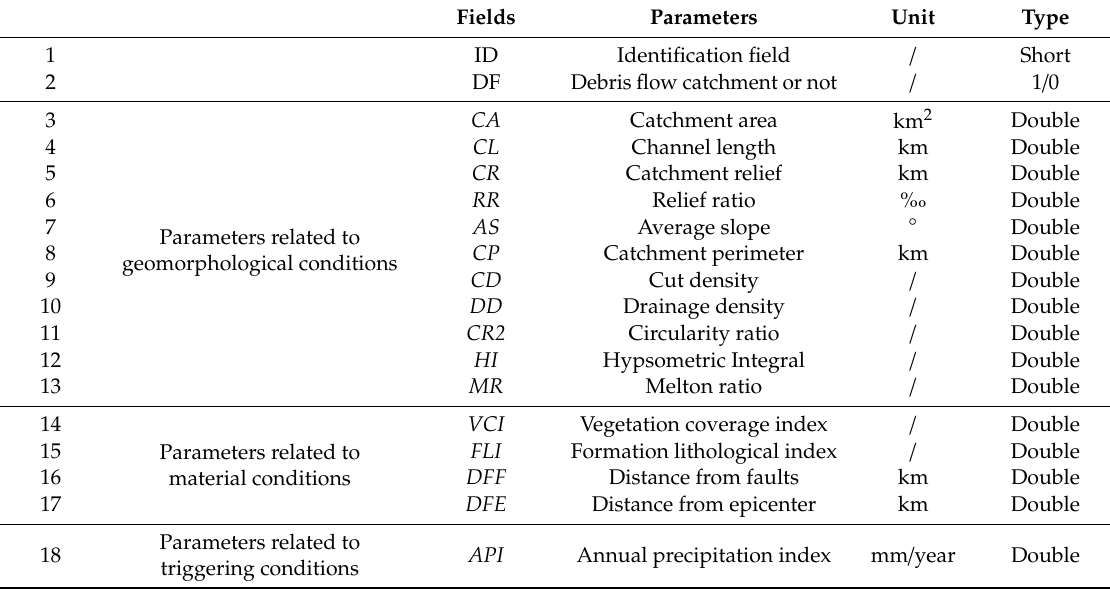
Table 2. Fields and characteristics of the spatial